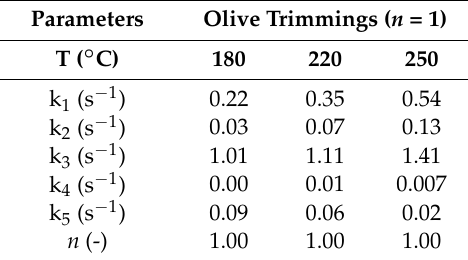
Table A2. Reaction rate constants (k i ) fixing reaction order ( n = 1) for the simplified reactions path of Figure 2 for olive trimmings.